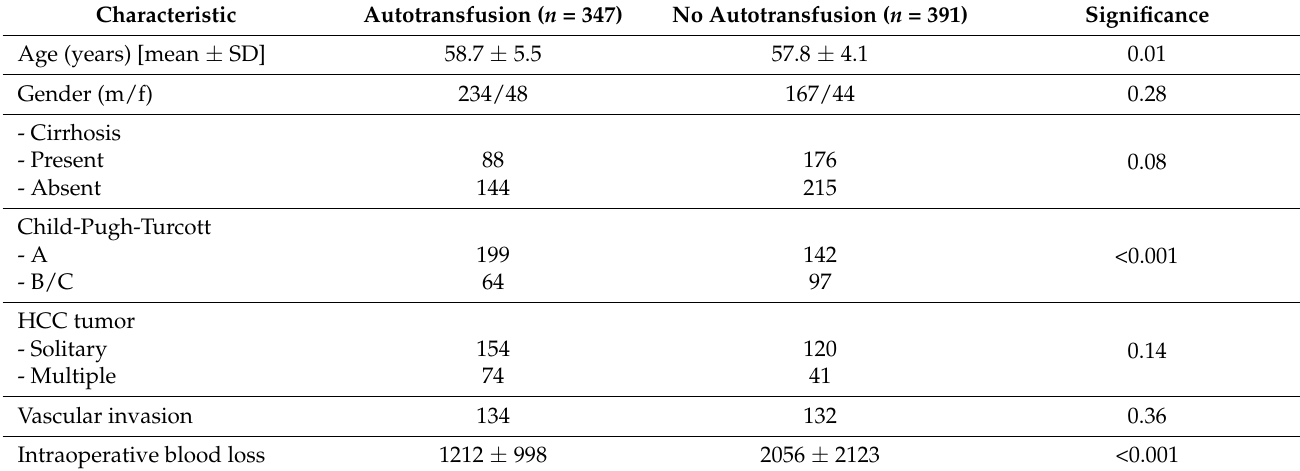
Table 3. Aggregated characteristics summary for hepatectomy